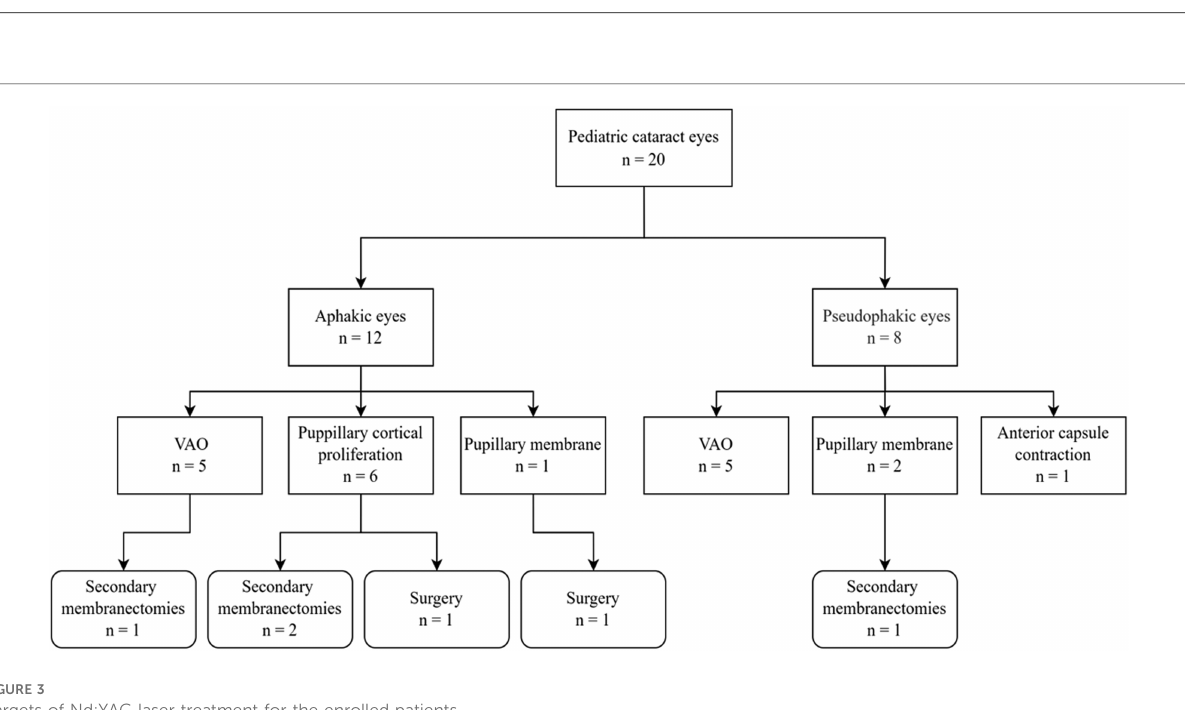
FIGURE 2 The preoperative ( A,C,E ) and postoperative ( B,D,G ) anterior segment con fi guration of patients. ( A,B ) Nd: YAG laser treatment of pupillary membranes along with anterior capsule remnants. ( C,D ) Nd:YAG laser posterior membranectomy was performed in a patient with posterior capsule capturing IOL implantation. ( E,F,G ) Nd:YAG laser treatment of anterior capsule contraction was performed in a patient with intracapsular IOL implantation, and iris hemorrhage occurred during treatment.